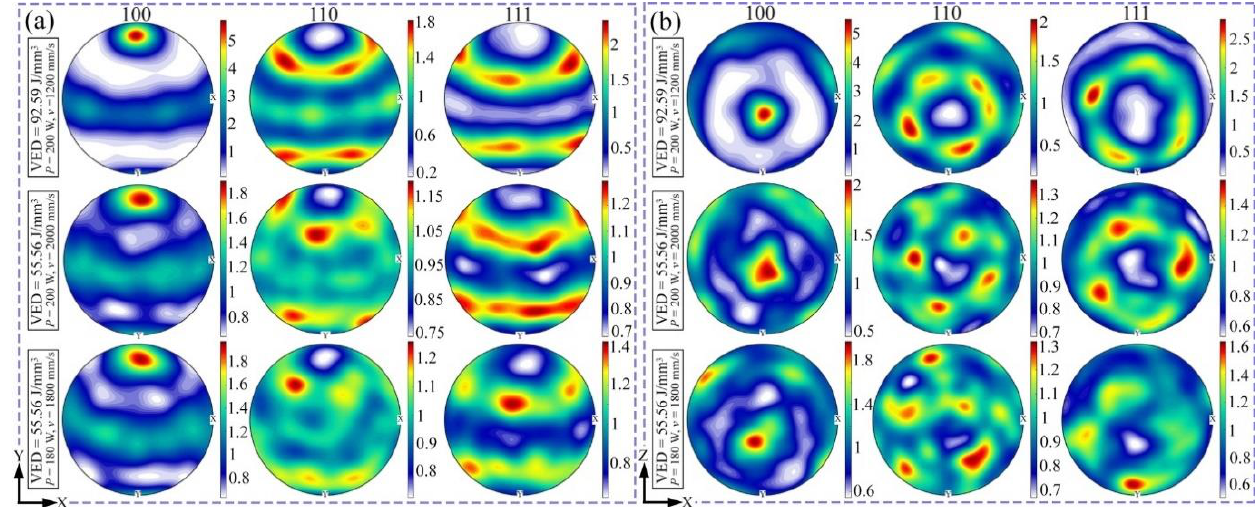
Figure 8. EBSD PF images of AlCoCr 0.75 Cu 0.5 FeNi specimens produced by different process param- eters on ( a ) xy- and ( b ) xz-plane.